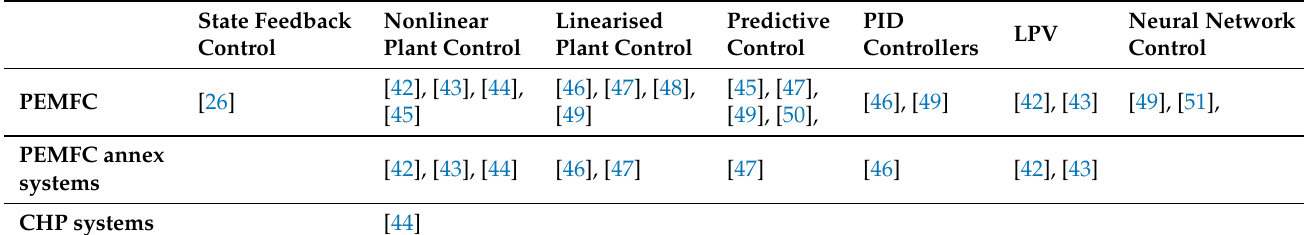
Table 3. Control strategies for PEMFC